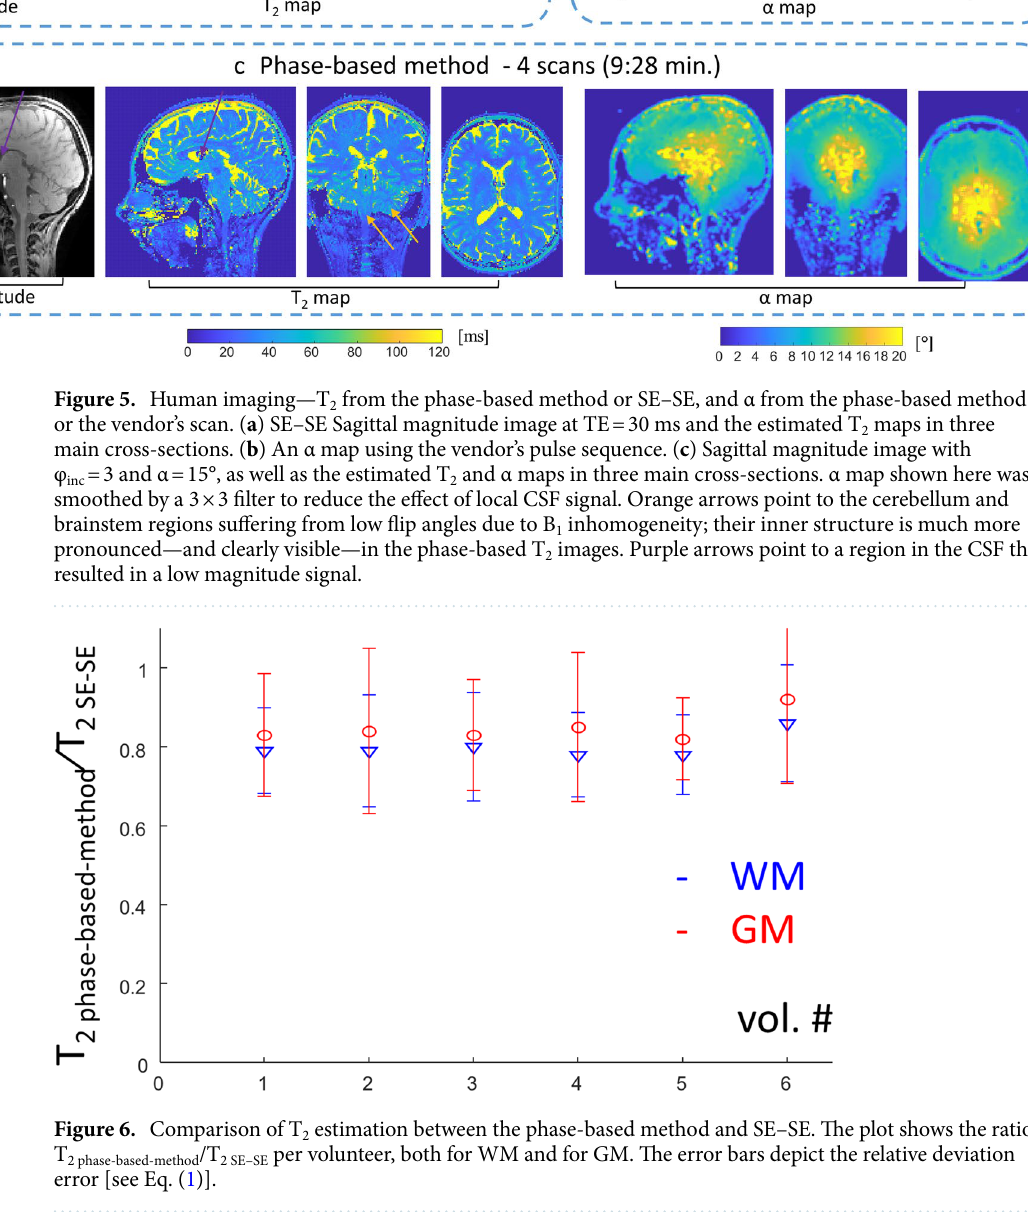
shows the 1 mm resolution images). To provide even higher robustness following the reduced SNR of the high- resolution datasets, we also incorporated denoising based on a DnCNN deep-learning network 33 (provided in 2 . The denoising greatly improved the observed details of the cerebellum structure, a region with especially low flip angles (Fig. 7b).